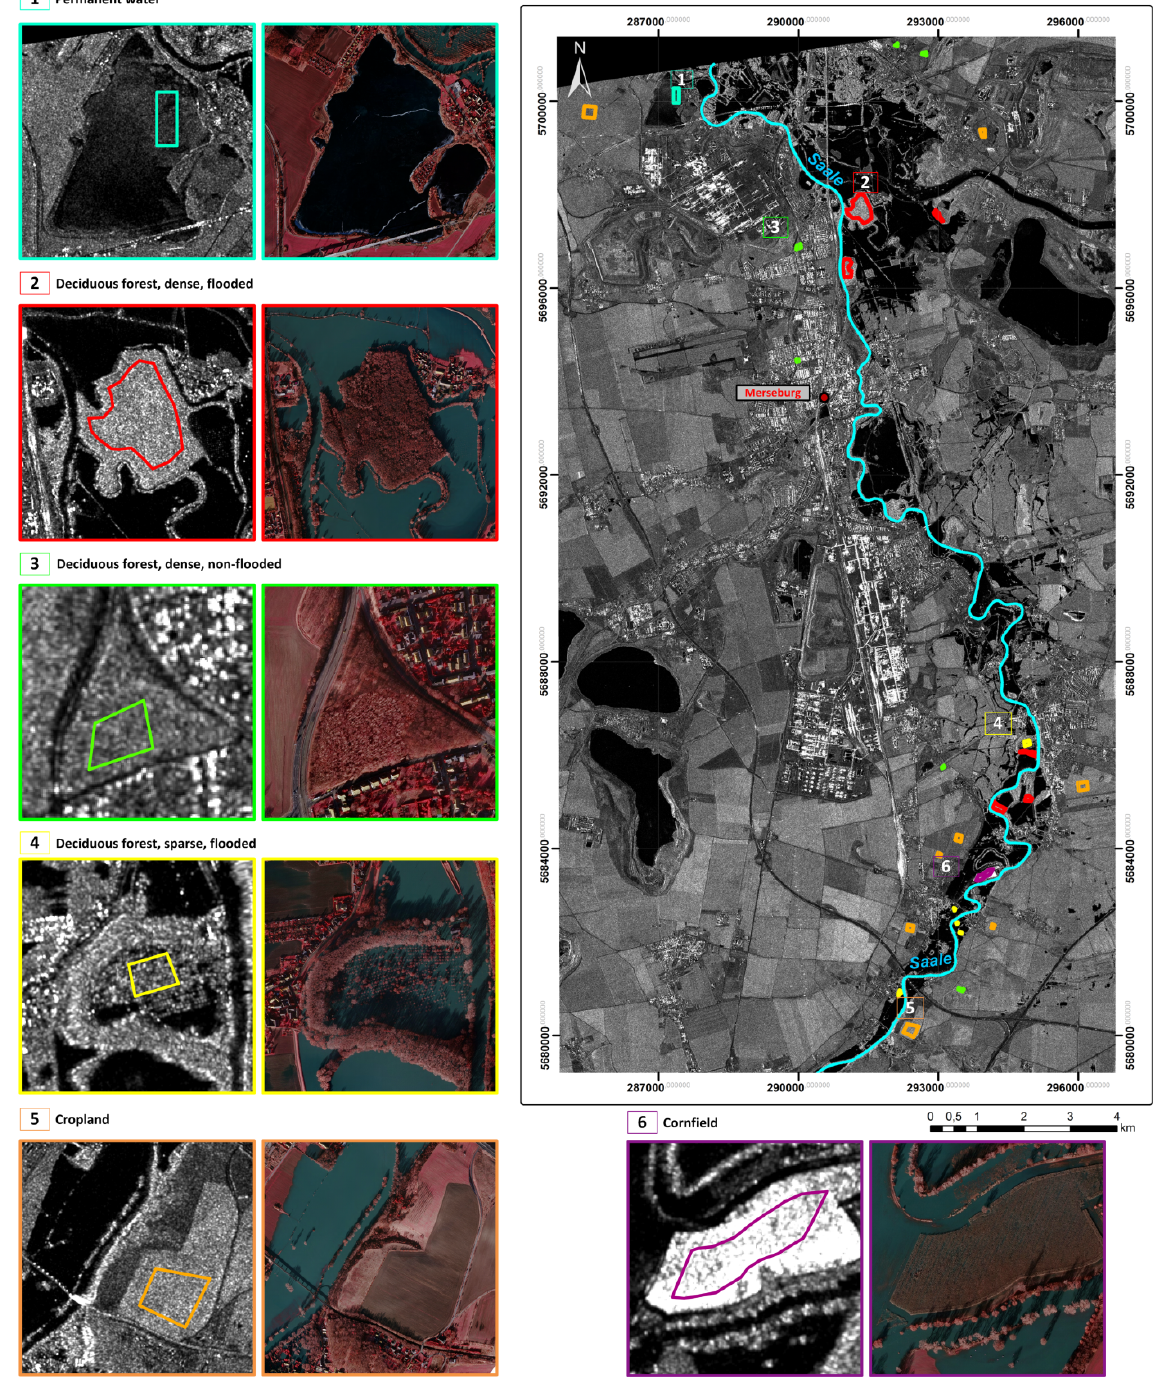
Figure 1. Study area at River Saale in Saxony-Anhalt, Germany, and visualization of test classes (polygons) in TerraSAR-X data (17 January 2011, © DLR 2014) and aerial photographs (17 January 2011 © LHW